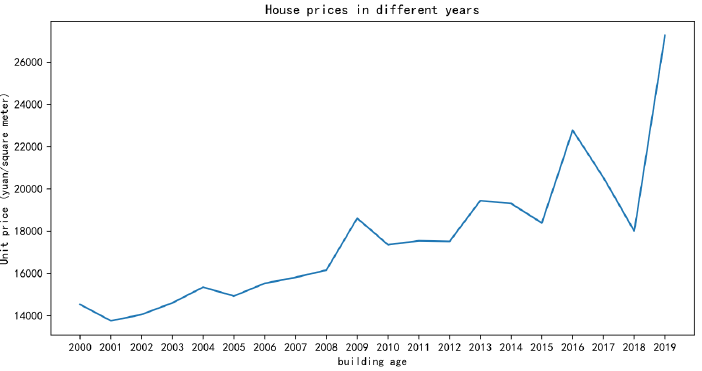
Fig. 12 House prices per unit area in various years